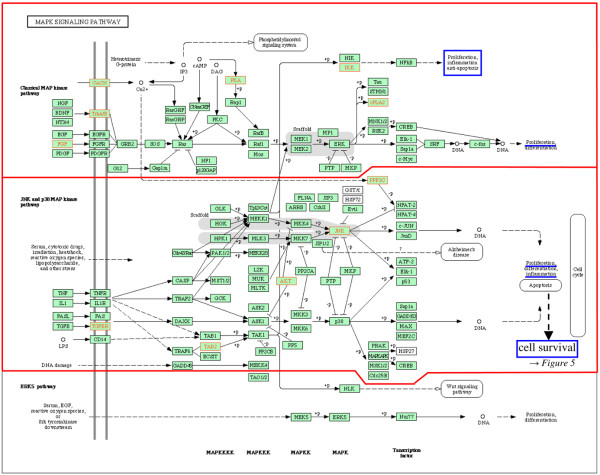
Inter-individual mRNA expression variances in the mitogen-activated protein kinase (MAPK) signaling pathway in rheumatoid arthritis (RA) compared with normal control (NC). The graph shows genes affected by significant intra-group inter-individual mRNA expression variances in RA compared with NC (P ≤ 0.05; Bonferroni/Holm corrected Brown-Forsythe version of the Levene test; labeled in red) in the Kyoto Encyclopedia of Genes and Genomes (KEGG) MAPK signaling pathway. Among the three MAPK family sub-pathways, the classical and the c-jun kinase (JNK)/p38 MAPK sub-pathways were significantly affected by gene expression variances (P ≤ 0.15, χ2 test; indicated in red). MAPK-regulated cellular processes with potential influence on or relevance for RA pathogenesis (for example, proliferation, inflammation, and anti-apoptosis) are labeled in blue.